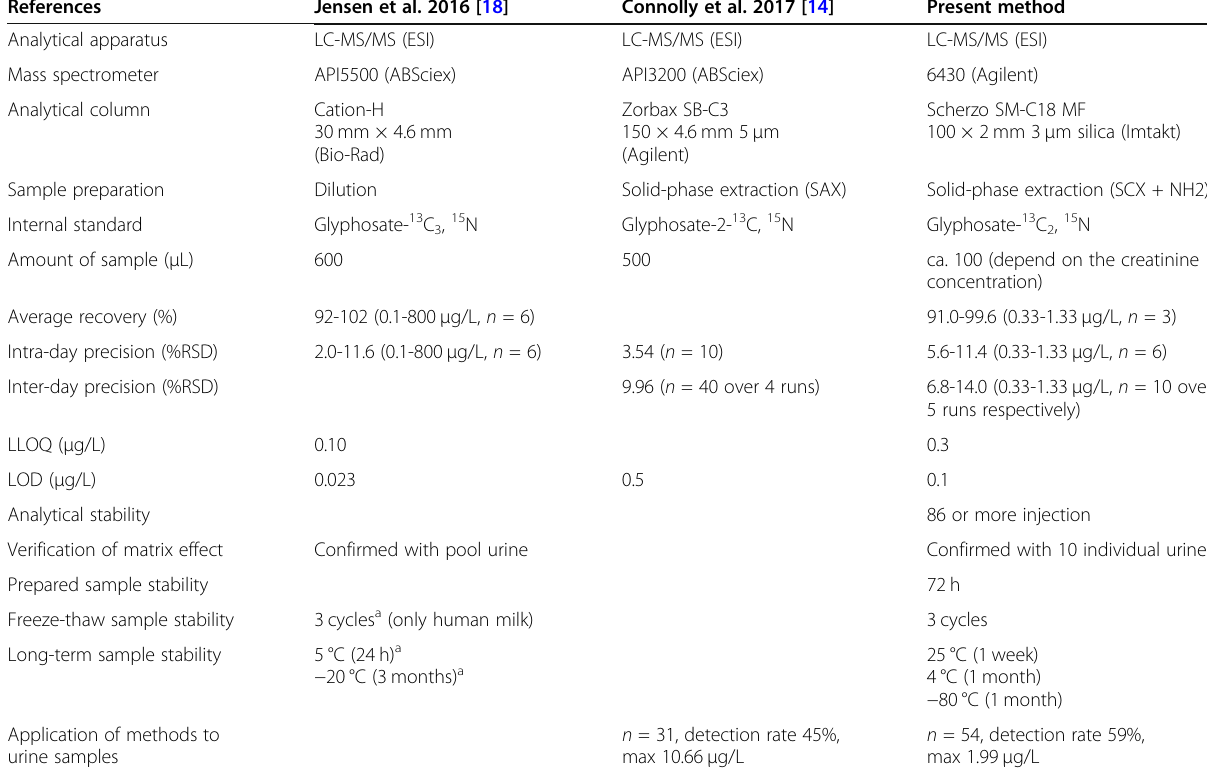
Table 7 Comparison of the present method with data obtained in two previously described methods